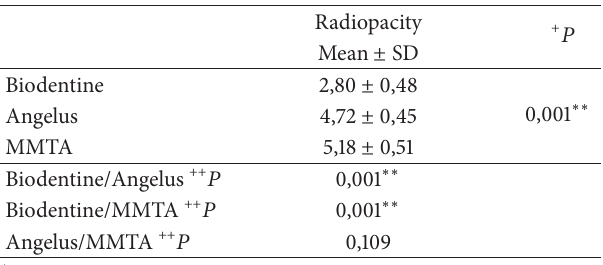
Table 1: Average radiopacity and SD associated with each tested material and comparison of different